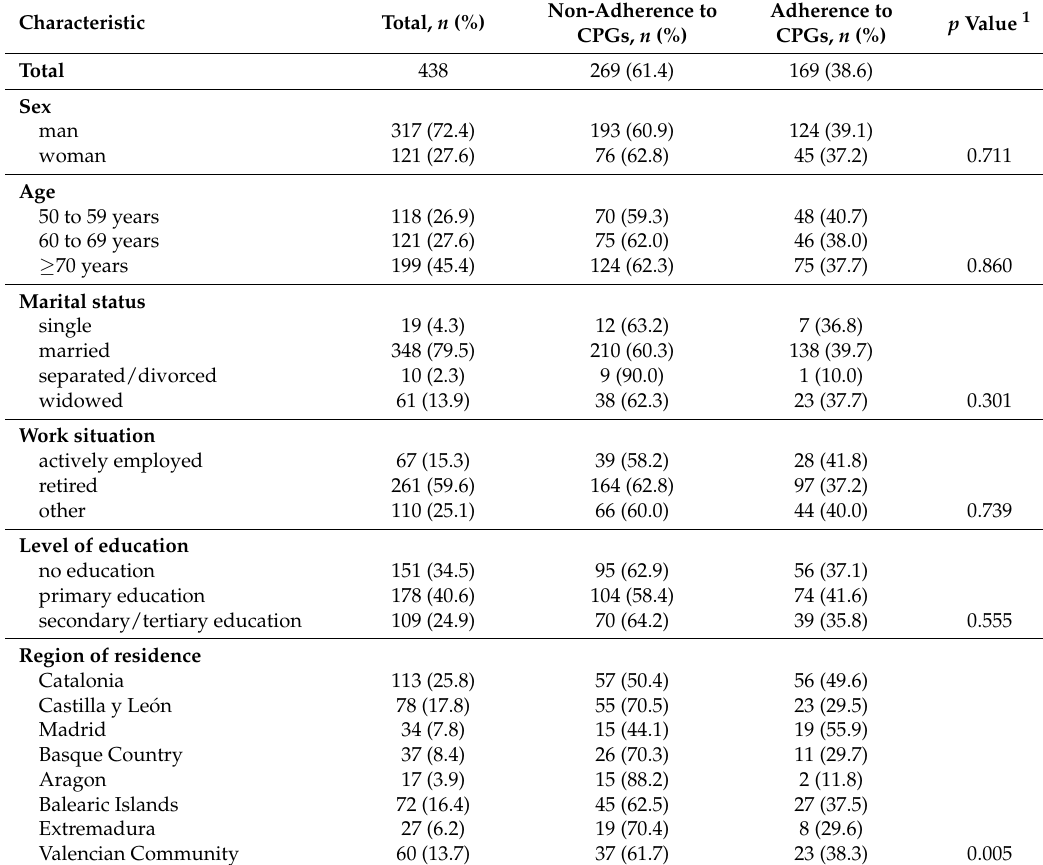
Table 1. Participants’ sociodemographic characteristics, by clinician adherence to clinical practice guidelines (CPGs) for secondary prevention of cardiovascular